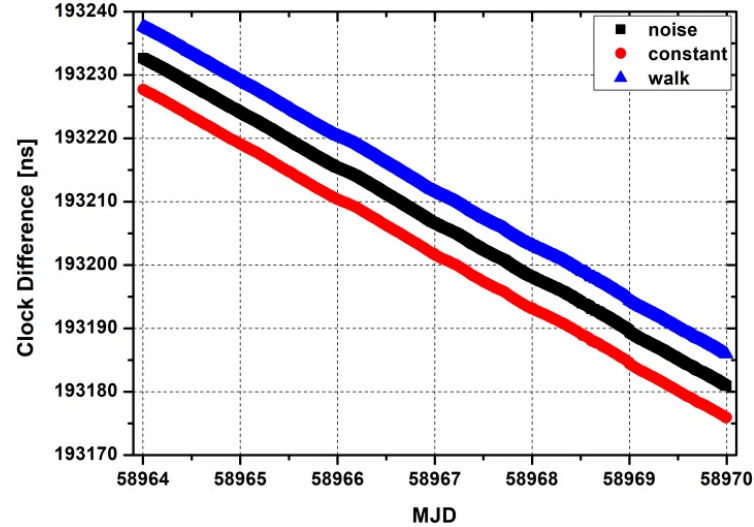
Figure 9. Result of time and frequency transfer with three ISB stochastic models on time link PTBB–WTZZ. For plotting purposes, the overall values for “walk” results were translated up to 5 ns, whereas those for results using the constant were translated down to 5 ns.